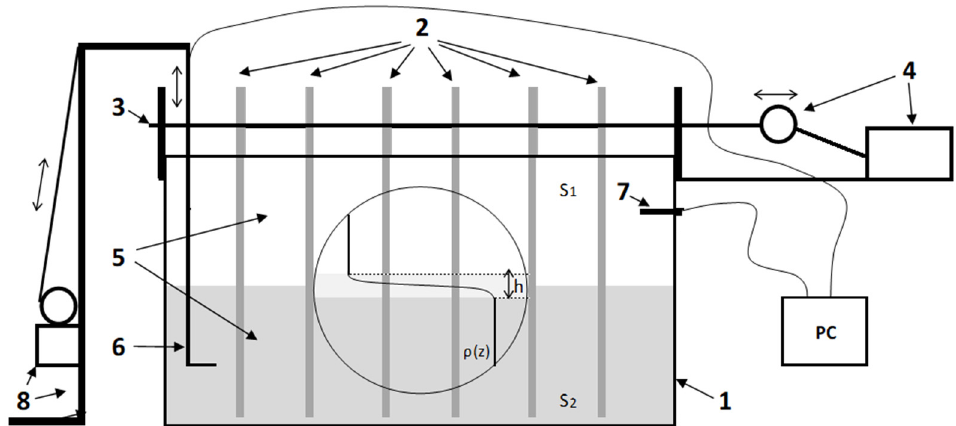
Figure 2. Experimental setup: 1 , an organic glass tank; 2 , a grid system with vertical glass rods; 3 , a metallic rod on which six grids with the glass rods are fixed; 4 , an electric motor with an eccentric providing horizontal oscillation of the metallic rod; 5 , two-layered fluid with an intermediate layer of a high density (salinity) gradient; 6 , single-electrode conductivity microsensor for measuring the salinity profile; 7 , four-electrode conductivity sensor for measuring salinity in the upper quasi-uniform layer; PC, personal computer for registration and processing of measured data; S 1 and S 2 , salinity of the upper and lower quasi-uniform layers; 8 , an elevator, which provides vertical displacement of the conductivity microsensor. The circle in the center of the tank indicates the section of the plane-parallel beam of light by the shadowgraph device.